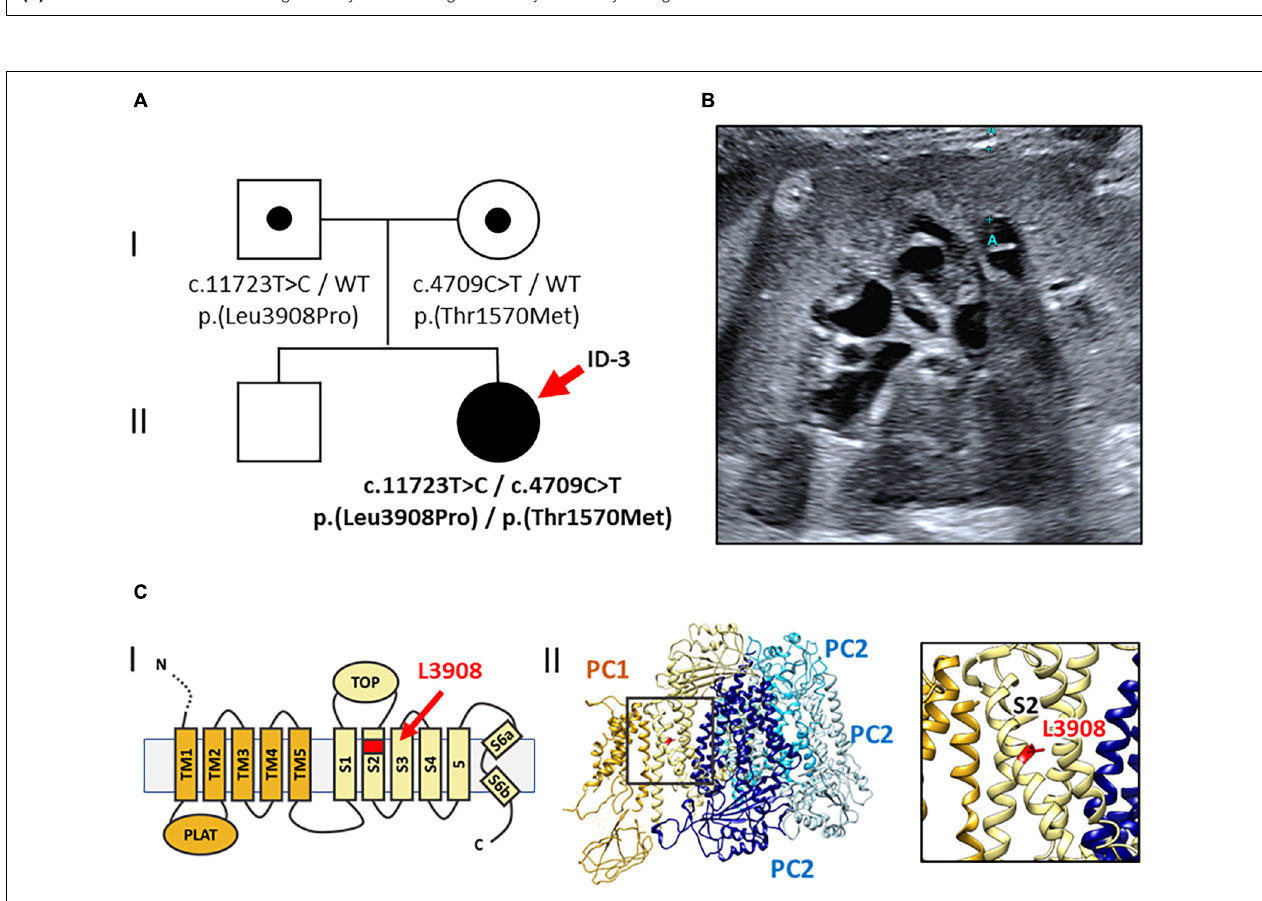
FIGURE 3 | Pedigree, renal imaging, and 3D-PC1-protein structure (Family 3). (A) Family pedigree: ID-3 (red arrow) with compound heterozygous rare PKD1 missense variants both of uncertain significance [NM_001009944.2: c.11723T > C, p.(Leu3908Pro) and c.4709C > T, p.(Thr1570Met)]. WT: wild-type. (B) Kidney ultrasound of ID-3 at the age of 19 years shows enlarged, microcystic-hyperechogenic kidneys. (C) Localization of the novel variant p.(Leu3908Pro) in the PC1 protein structure. (I) Schematic illustration of the PC1 transmembrane region; L3908 is located in transmembrane helix S2 (red arrow). (II) Cryo-EM structure of human PC1/PC2 complex (pdb 6A70) (left) and zoom-in view (right) showing the position of L3908 in helix S2 (red) (Su et al., 2018).